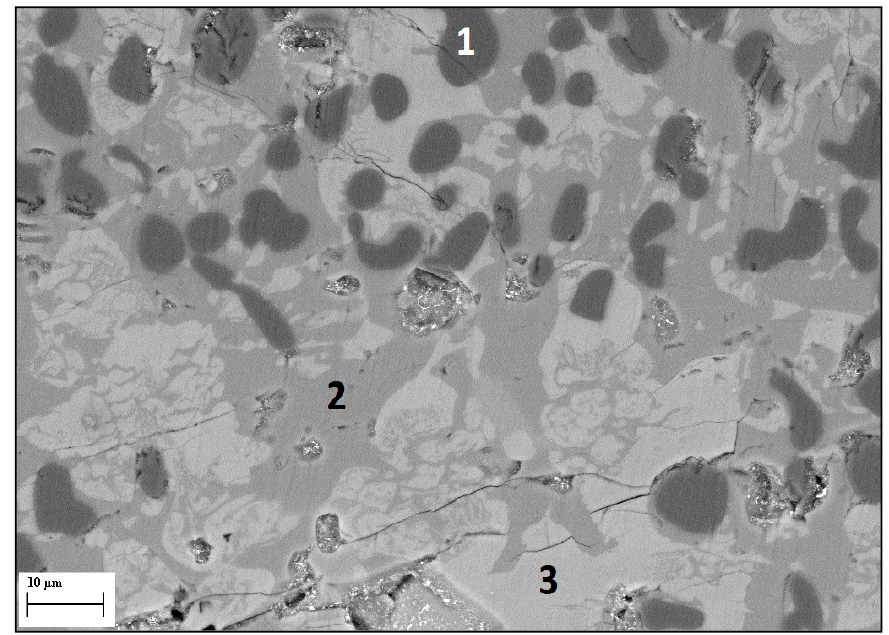
Figure 3. SEM image of a directionally solidified rod grown at 50 mm/h. Table 3. EDS analysis (atom %) for directionally solidified rods at 50 mm/h.